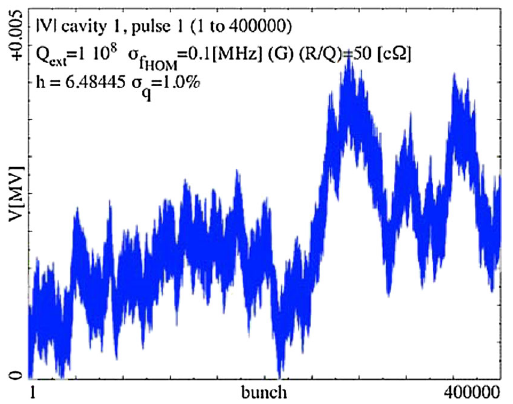
FIG. 62. (Color) dt at ejection [ (cid:3) 3 ps ] corresponding to dE of Fig. 60 (pulse 2). The envelope increases with bunch number (time) but does not start with zero amplitude since for Q ext ¼ 10 8 fields of the last pulse survive.